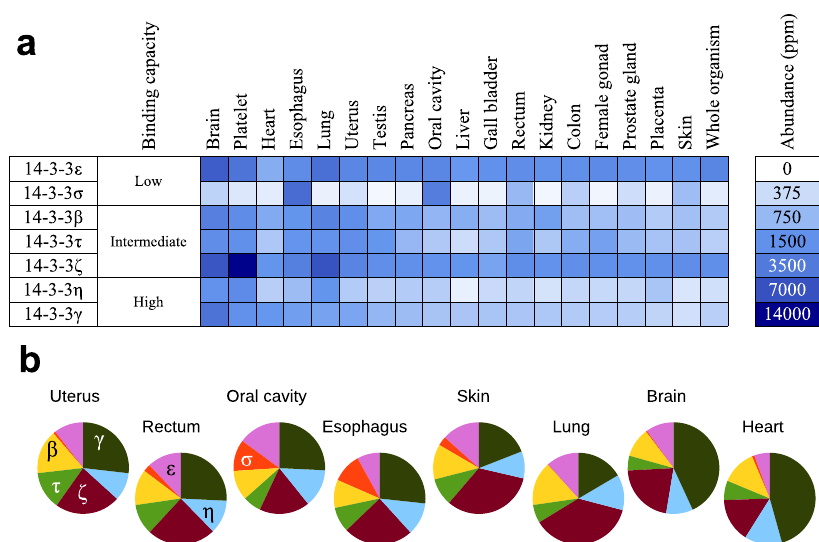
Fig. 5 Cellular 14-3-3/phosphotarget complexomes. a Abundance of the seven 14-3-3 isoforms across different human tissues and in the whole human organism, according to the PAXdb database (https://pax-db.org and 3 ). Colors correspond to the protein abundances, according to the scale provided on the right. b Predicted proportions of 14-3-3-bound phosphoproteins that would be engaged with each individual isoform in different tissues, assuming that the majority of 14-3-3 molecules are available for interaction (same color code as in Fig. 4d). Source data are provided as a Source Data fi